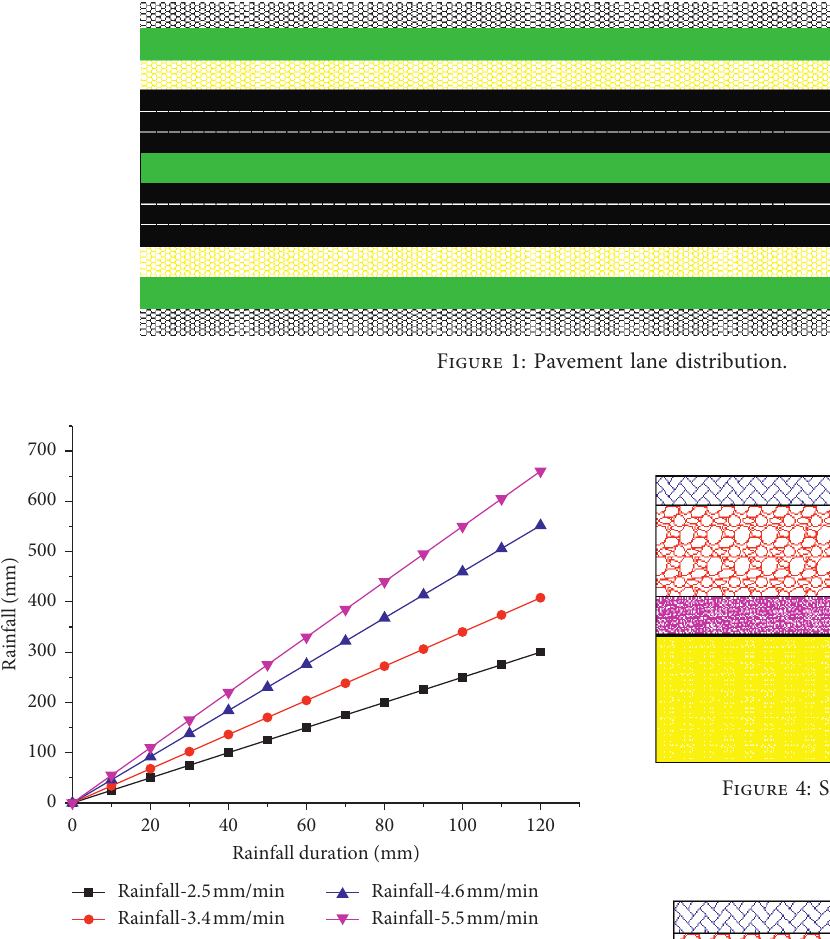
Figure 2: The relationship between cumulative rainfall and rainfall duration.